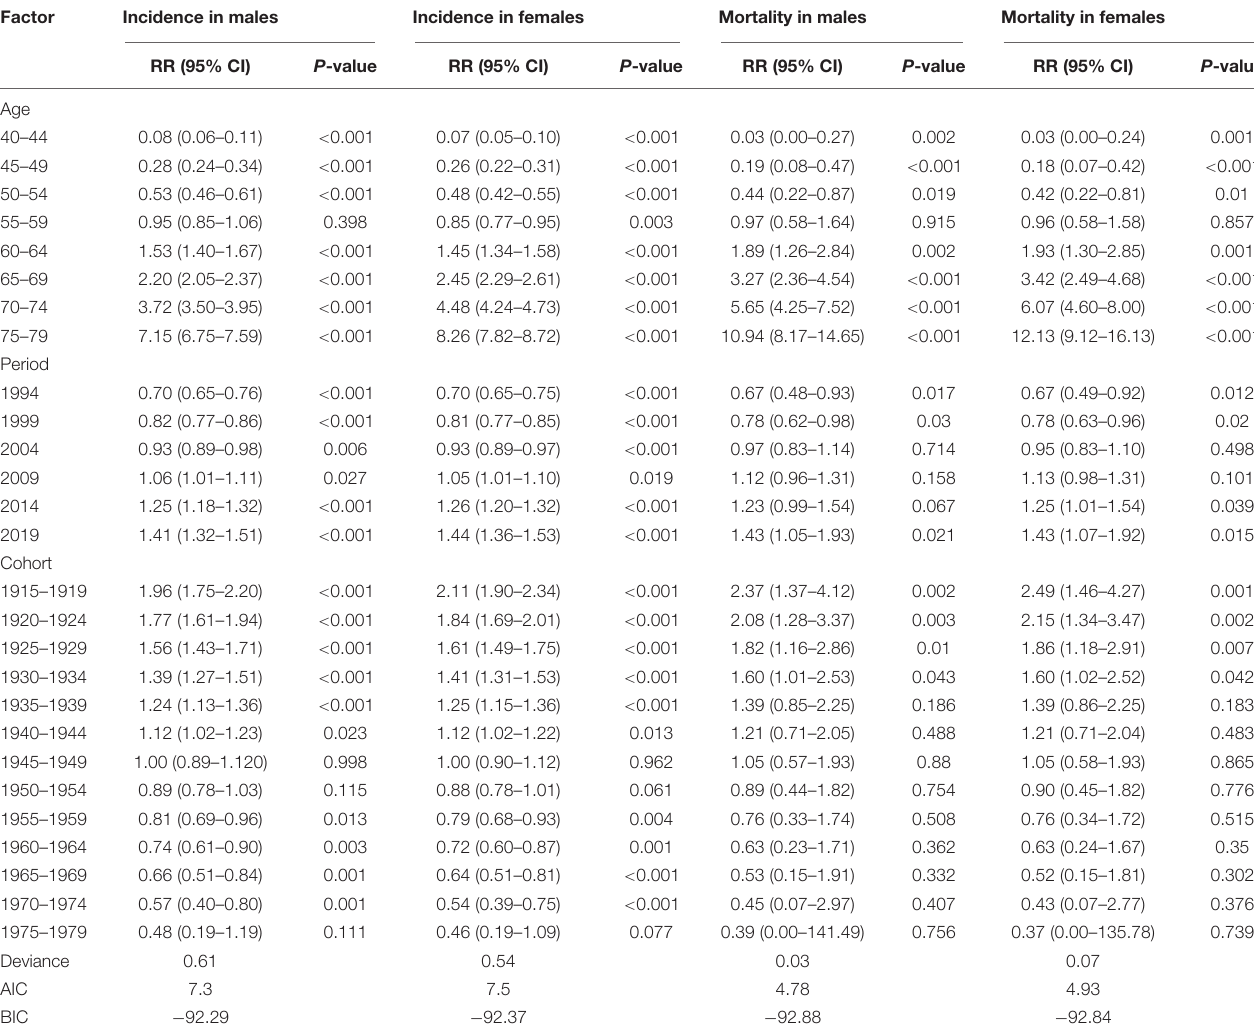
TABLE 2 | Sex-specific relative risks of the incidence of and mortality due to Alzheimer’s disease and other forms of dementia in China due to age, period, and cohort effects. Factor Incidence in males Incidence in females Mortality in males Mortality in